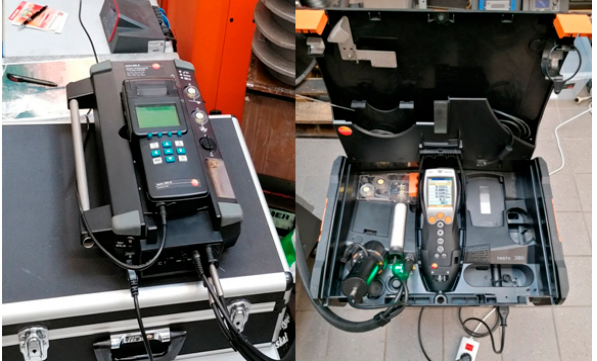
Figure 4. Exhaust gas analyzers used in tests. On left side: Testo 350s; on right side: Testo 380 and Testo 330 ‐ 2 LL.